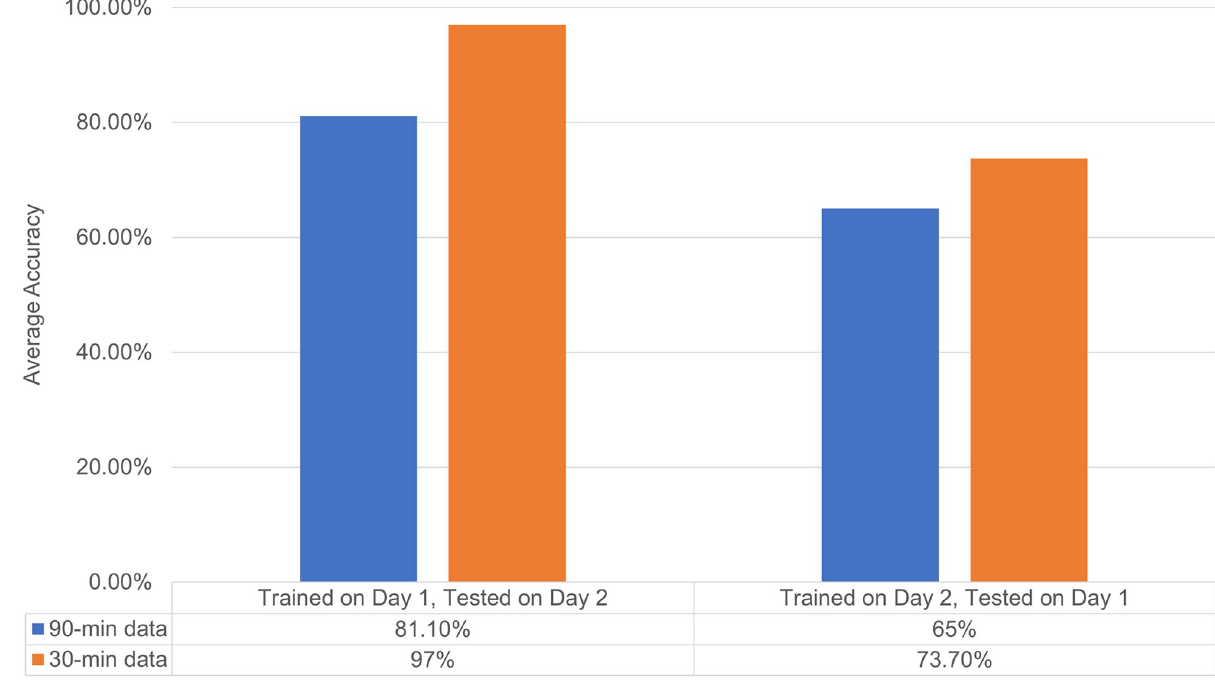
Fig 7. Cross-validation accuracies between days for 90-min and 30-min measurements.